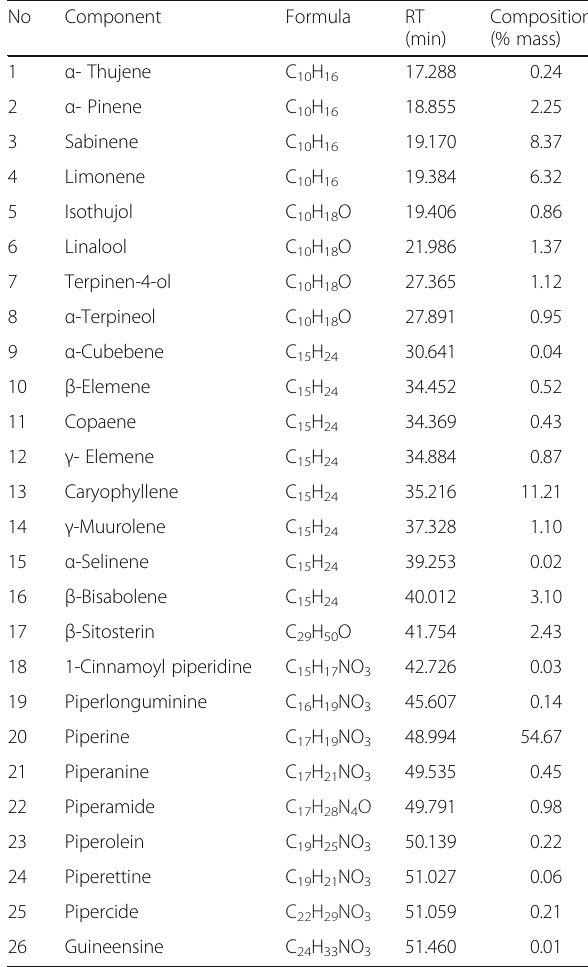
Table 2 L 9 (3^4) experimental matrix, response and SN-ratio Exp. no. Control factors